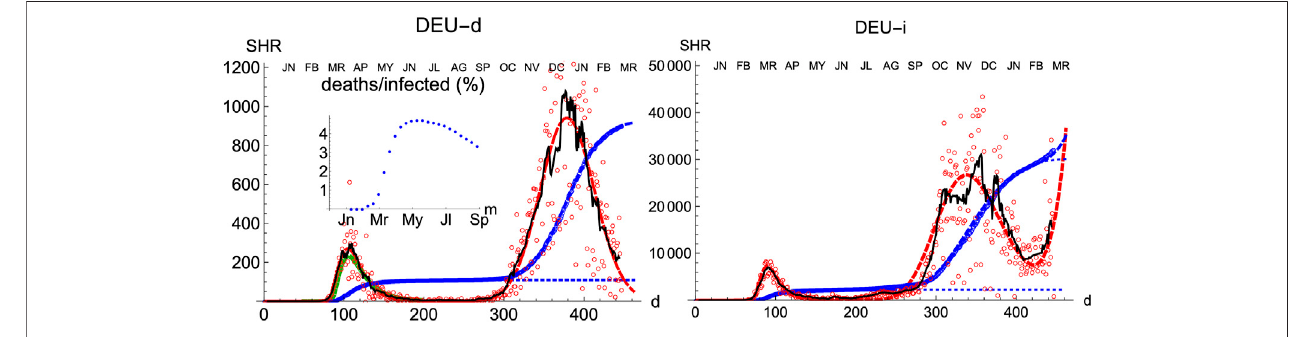
FIGURE 2 | SHR/Germany. Symbols as in Figure 1